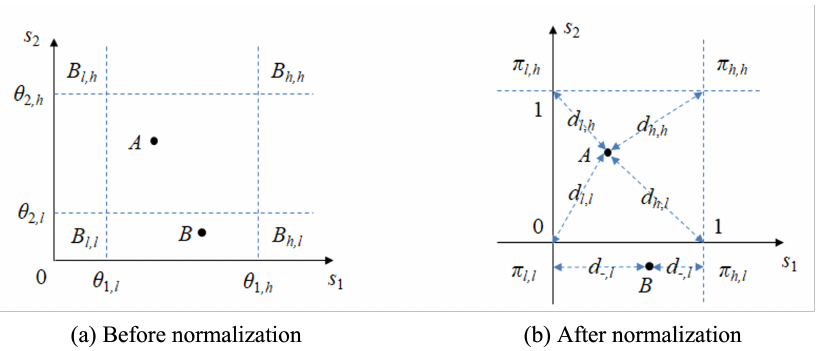
Figure 6. Situation space displayed on a two-dimensional plane formed by the two coordinates of the situation indicators s 1 and s 2